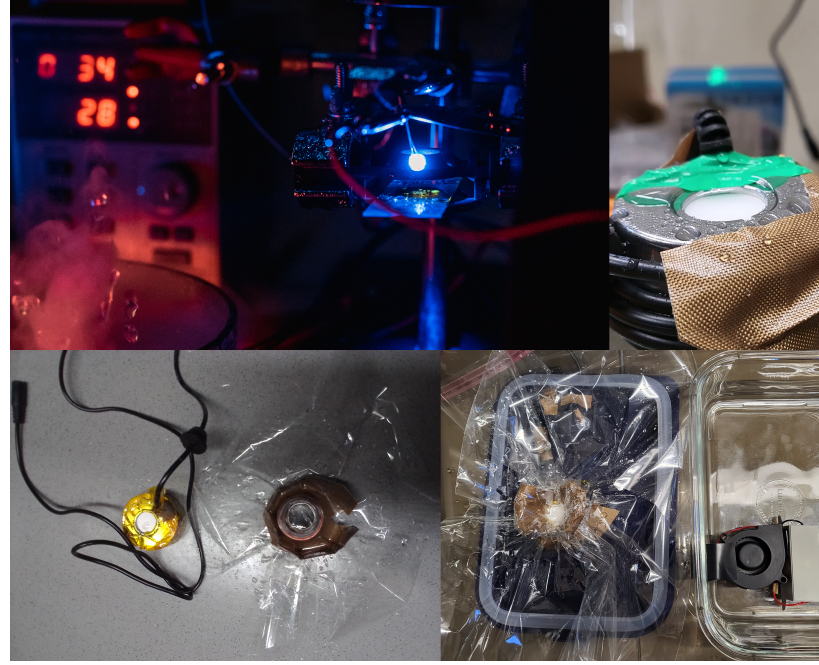
Figure 10. Ultrasonic atomizer and barriers used to protect it from